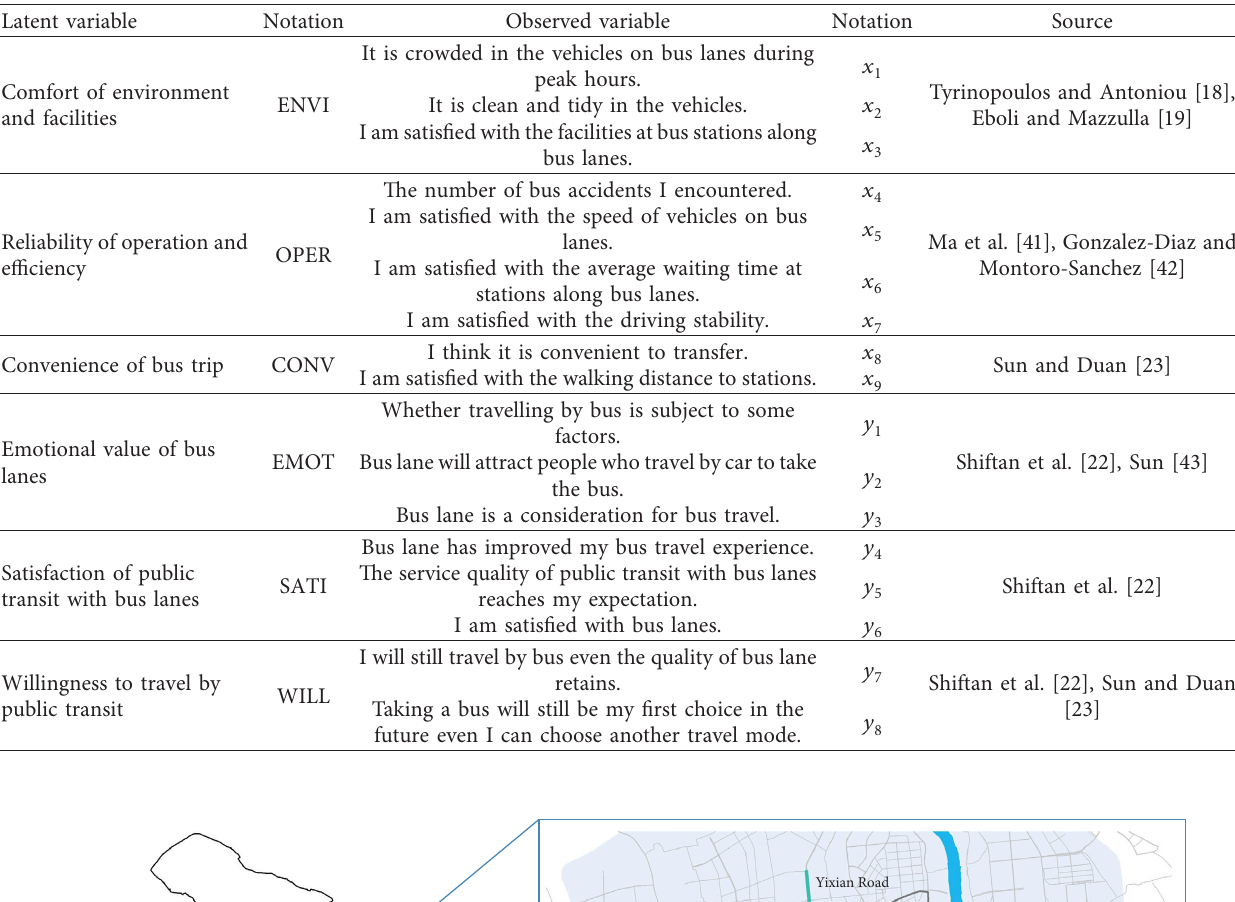
Table 1: Observed variables in the